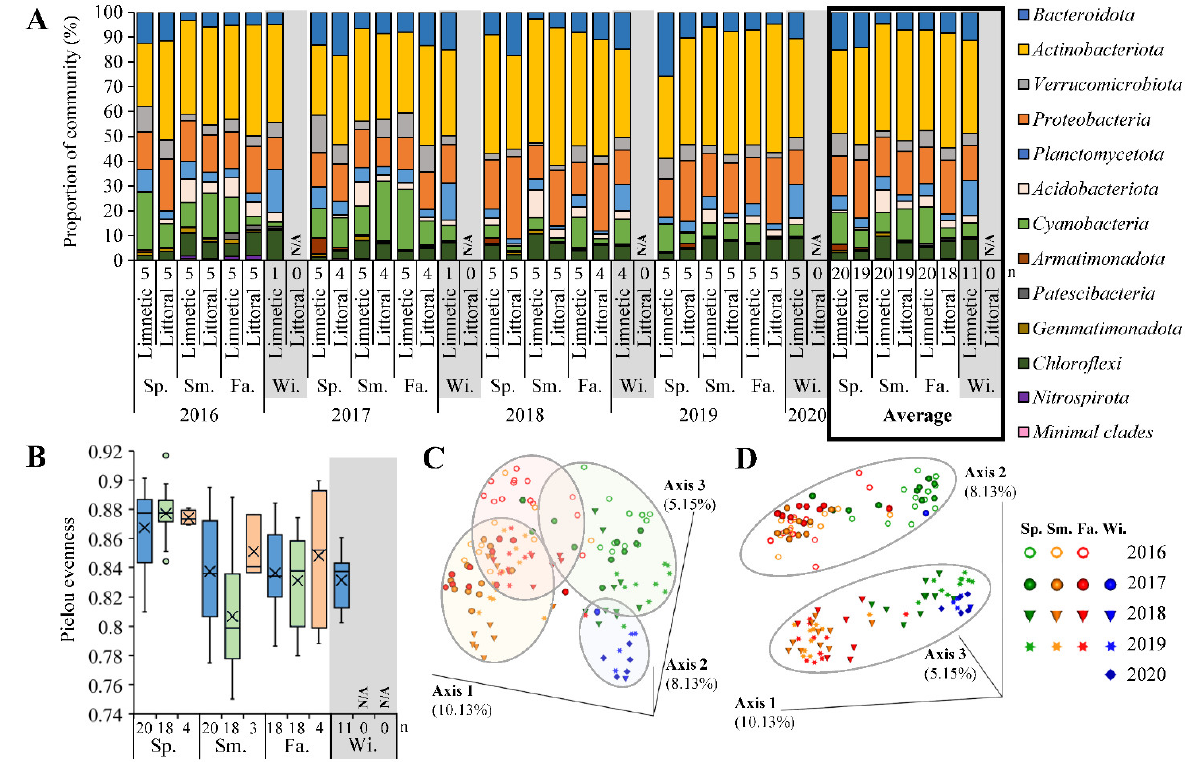
Figure 5. Bacterial community composition based on sequenced 16S V4 rRNA genes. ( A ) Phyla in water samples defined at limnetic vs. littoral sites. Minimal clades represented less than 1% per community with Firmicutes, Deinococcota, Bdellovibrionota, Crenarchaeota, Desulfobacterota, Hydrogenedentes, Margulisbacteria, Myxococcota, Sumerlaeota, SAR324, MBNT15, and NB1-j clades. ( B ) Total α-diversity of bacteria from limnetic water (blue), littoral water (green), or sediments (orange). ( C , D ) PCoA ordination based on Jaccard diversity distance matrix with percent variation as principal coordinates split on indicated axis. ( C ) From above axis 1 and 3 separate seasons, while ( D ) depicts major shift occurring along axis 2 by year with ellipses as visual cues. N/A, not analyzed; n, number of samples per season; Sp., Spring; Sm., Summer; Fa., Fall; Wi., Winter.